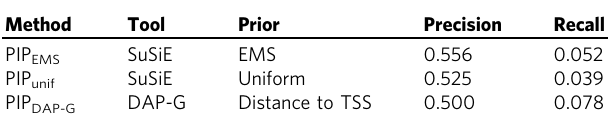
Table 1 Precision and recall of the gene prioritization task for three different